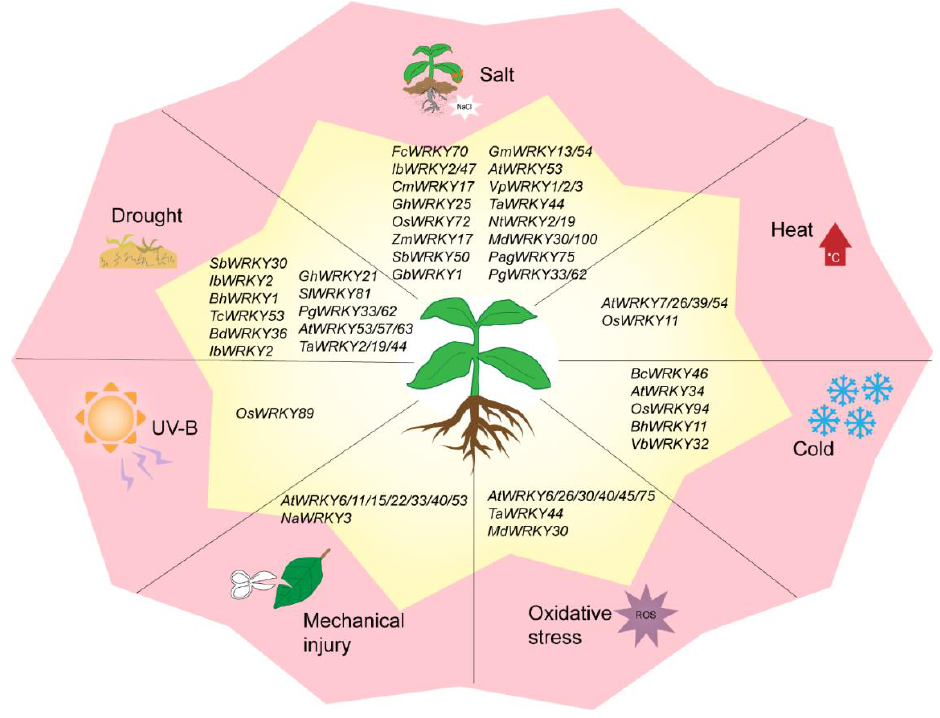
Figure 3. WRKY transcription factors in response to abiotic stresses.